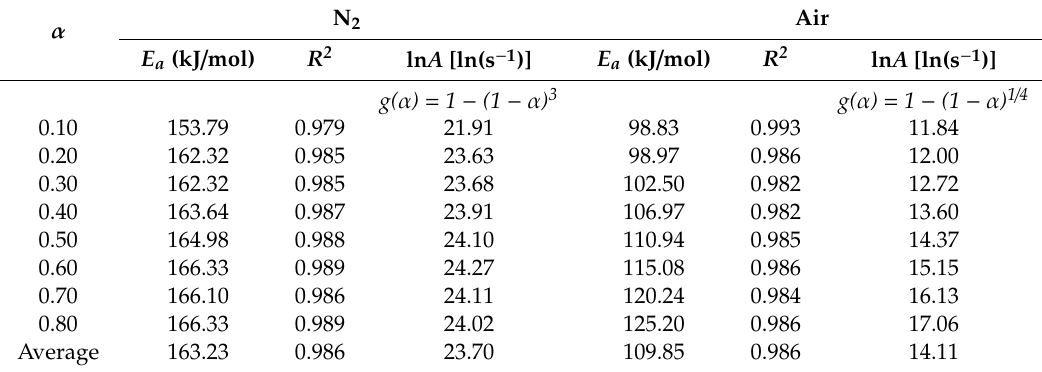
Table 3. The values of E a and ln A of the Flynn–Wall–Ozawa (FWO) method.